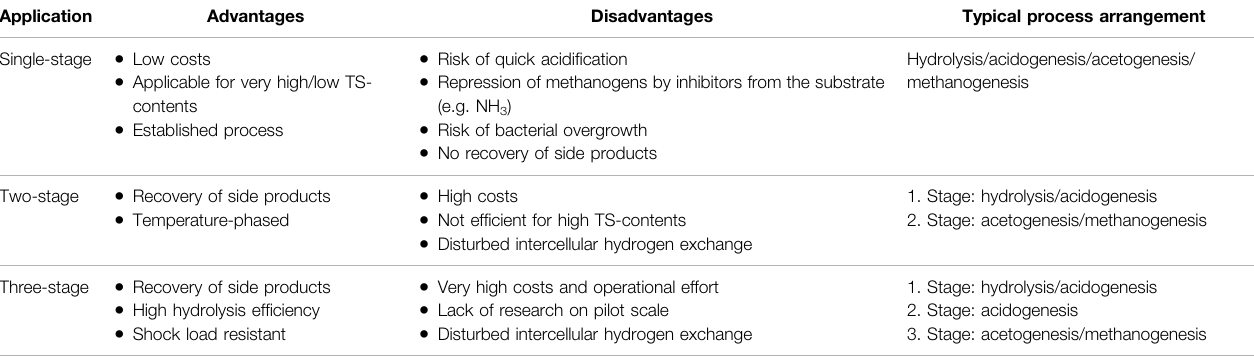
TABLE 1 | Characteristics of stage separation in anaerobic